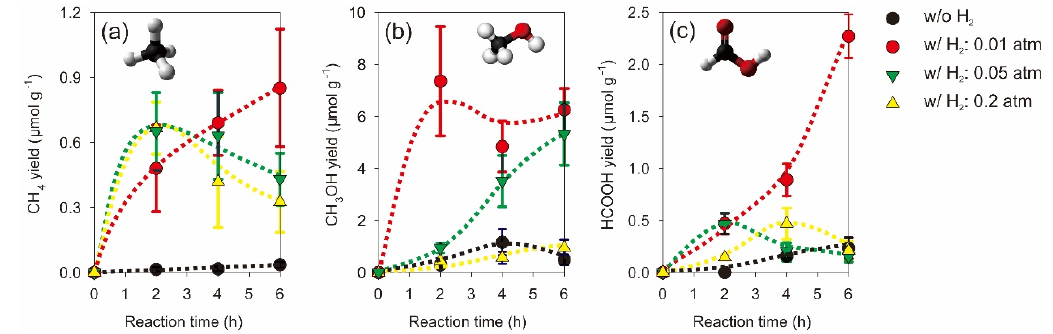
Figure 7. The time ‐ dependent yield of ( a ) CH 4 evolution, ( b ) CH 3 OH formation, and ( c ) HCOOH formation over 1 wt % Pt/CuAlGaO 4 photocatalyst under different H 2(g) partial pressures in a liquid phase reactor. Lines are not based on a kinetic model and are presented for eye ‐ guiding only.